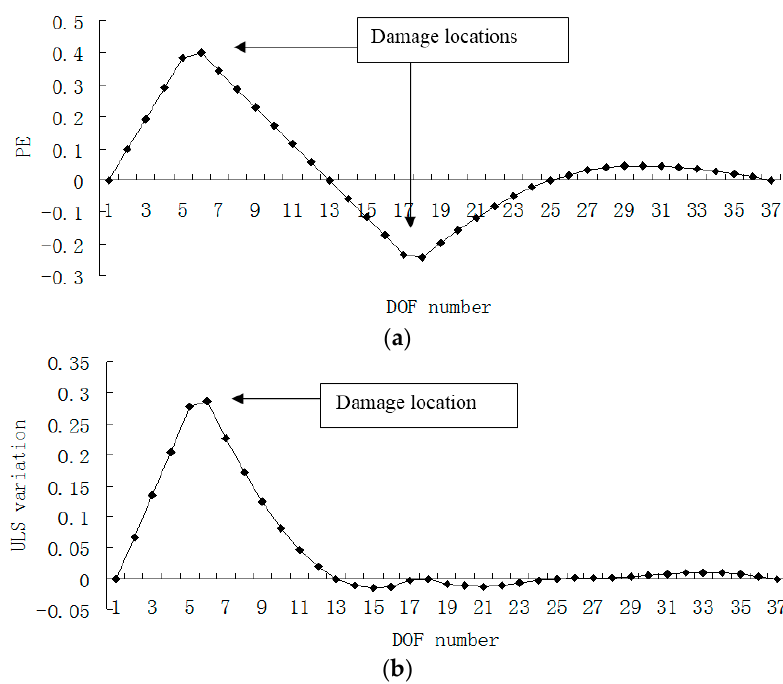
Figure 9. ( a ) Damage index (PE) map using the first four exact modes when the defects occurred in elements 5 and 17; ( b ) Damage index (ULS variation) map using the first four exact modes when the defects occurred in elements 5 and 17 (×10 − 4 ).